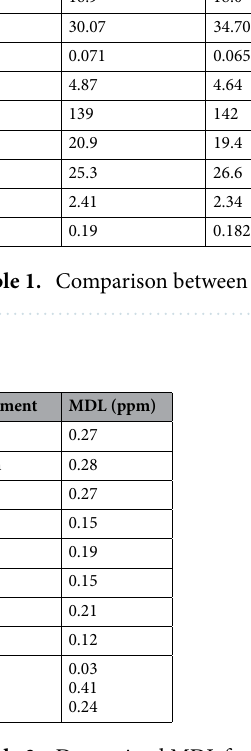
Table 2. Determined MDL for fish